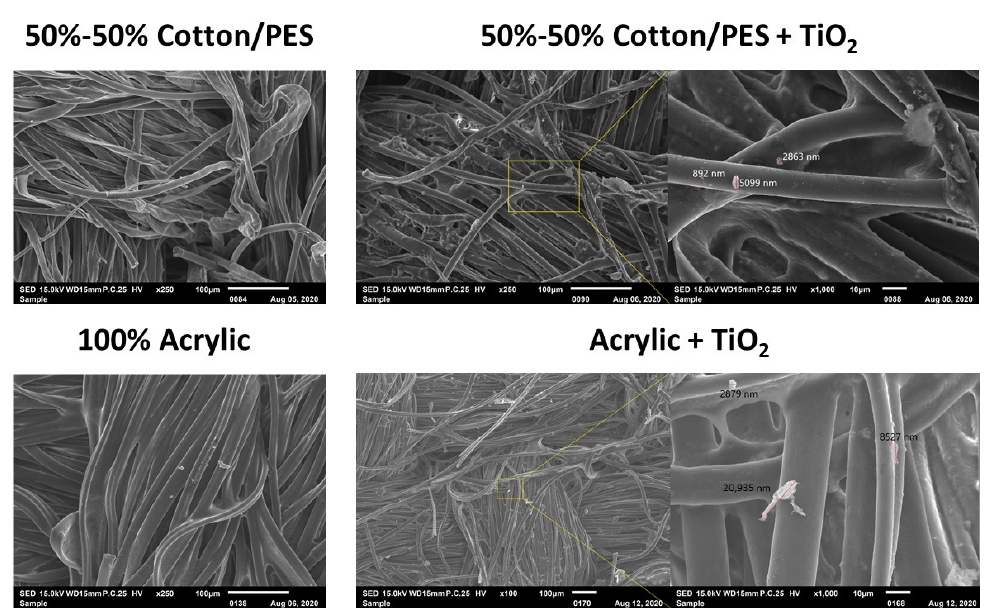
Figure 2. SEM images of uncoated fabrics and related TiO 2 ‐ coated fabrics.